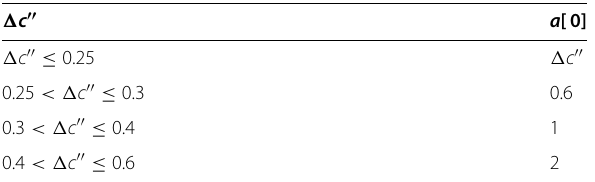
Table 3 The mapping from (cid:2) c (cid:2)(cid:2) to a [ 0]